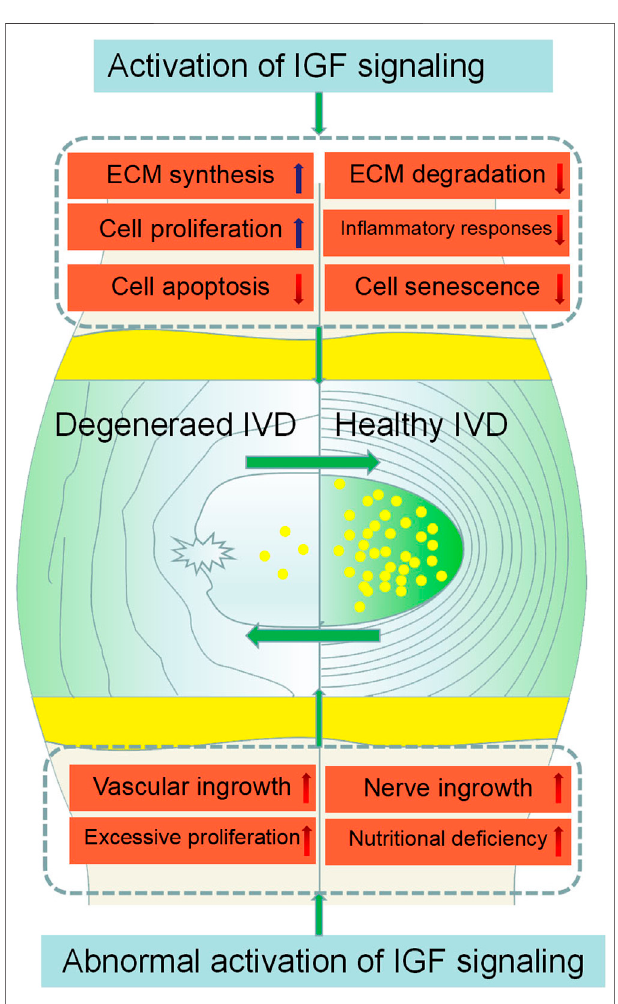
FIGURE 3 | Effects of IGF signaling on IVDD initiation and progression. IGF signaling activation inhibits IVDD by promoting ECM synthesis, cell proliferation, and inhibiting in fl ammatory responses, ECM degradation, and cell apoptosis. However, the abnormal activation of IGF signaling can accelerate the degeneration of IVD by stimulating excessive cell proliferation, increasing vascular and nerve growth, aggravating nutritional de fi ciency.